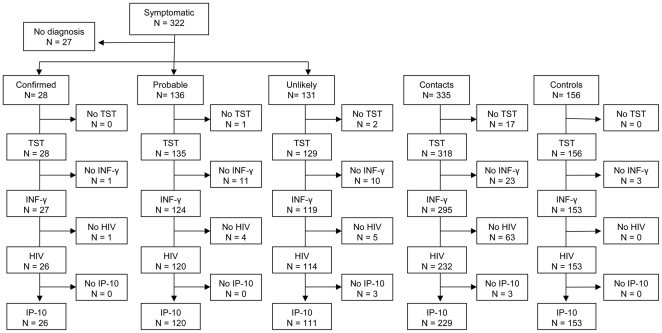
Flow chart of study participants.